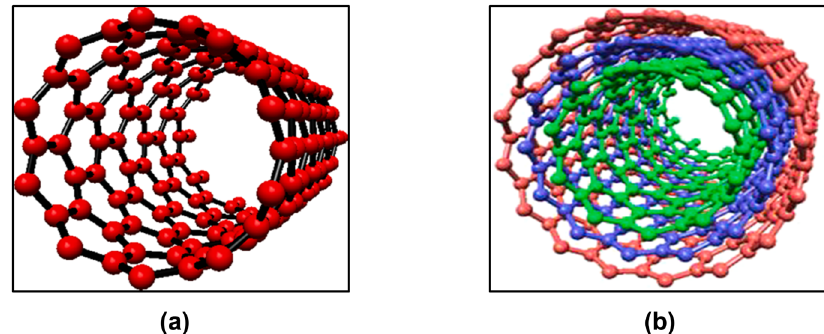
Figure 1: ( a ) Structure of SWCNT and ( b ) structure of